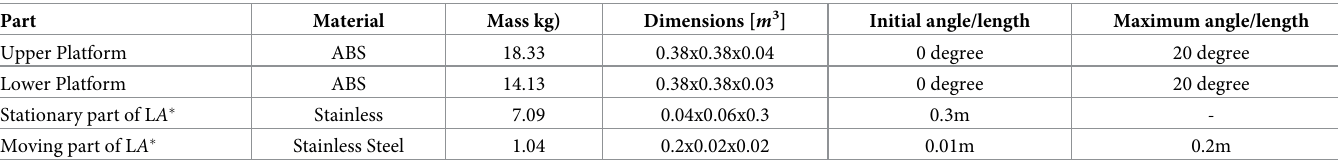
Table 3. Dimensions of 3-DoF parallel manipulator, LA � : LinearActuator